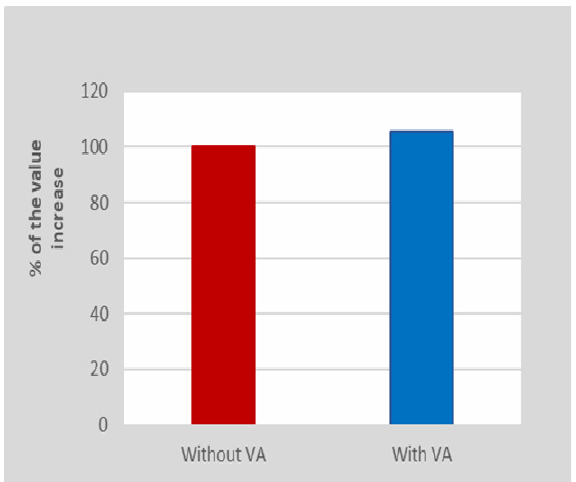
Figure 6. Average increment of the value of the final resources systems.